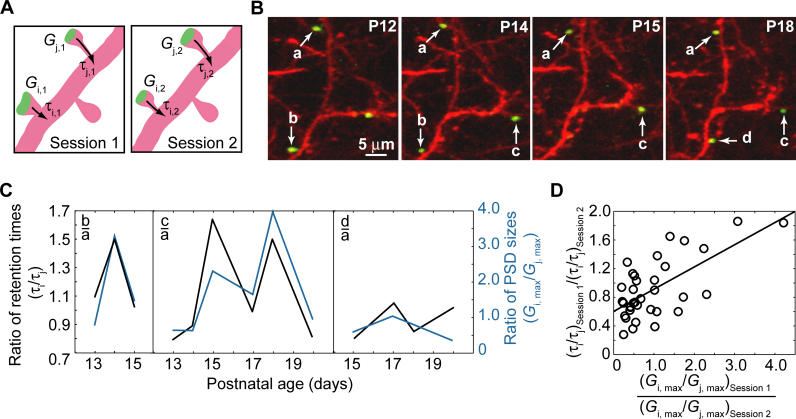
PSD Size and PSD-95 Retention Time Vary Together from Day to Day(A) Schematic of the experiment. Spines (i and j) on the same dendrite were photoactivated to measure PSD-95 fluorescence (G
i,j) and the PSD-95 retention times (τ
i,j). The ratios G
i/G
j and τ
i/τ
j were compared across imaging sessions.(B) Example of repeated imaging and photoactivation of three spines over 6 d.(C) Ratios of retention times (black) and ratios of PSD sizes (blue) for pairs of spines as a function of age (same experiment as [B]).(D) Changes in fluorescence retention time predict changes in PSD size between imaging sessions 1 d apart. The line is a least-squares fit to the data (n = 4 animals, 18 spine pairs, 35 2-d sequences).